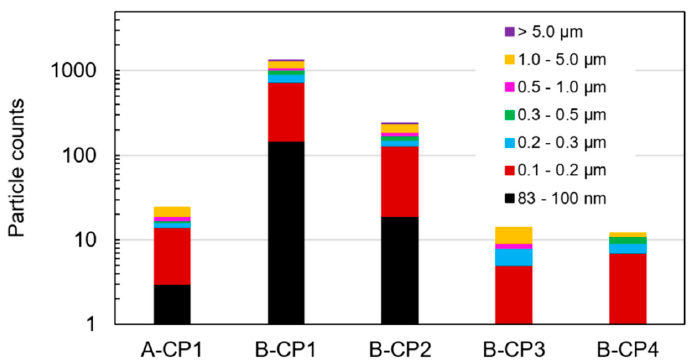
Figure 2. Particle counts for cleaning processes A-CP1 to B-CP4 in a logarithmic scale.